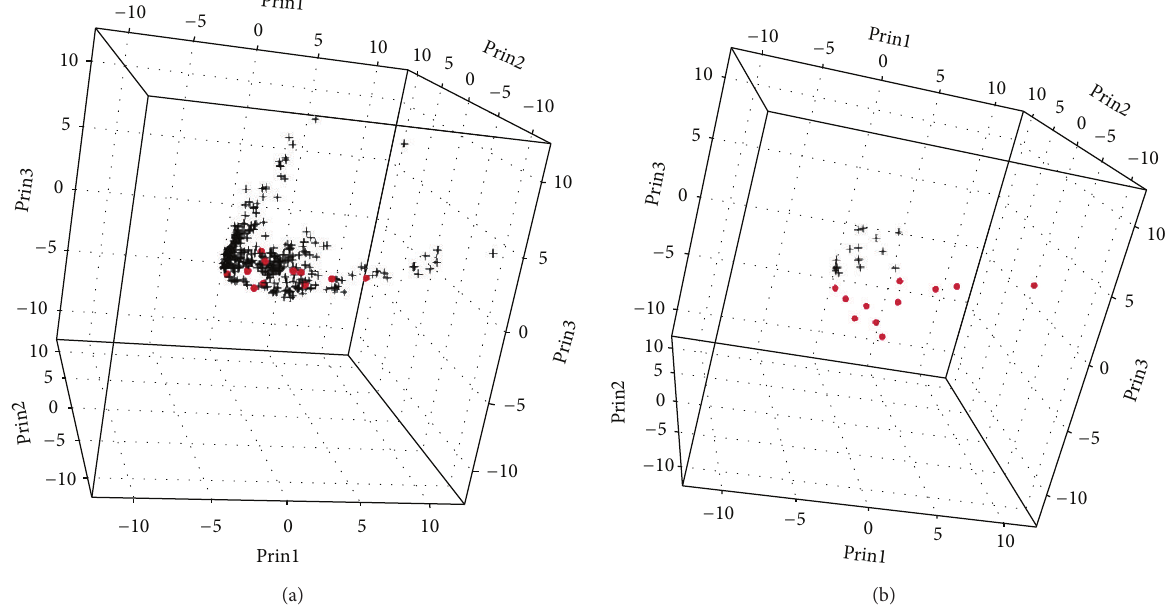
Figure 1: Principal components analysis of individual samples grouped by “pregnant” (+) versus “nonpregnant” ( ∙ ). In (a, left), all samples are plotted with no clear separation of the groups. When only the baseline first trimester samples are plotted against the nonpregnant controls (b, right), a separation between the groups becomes